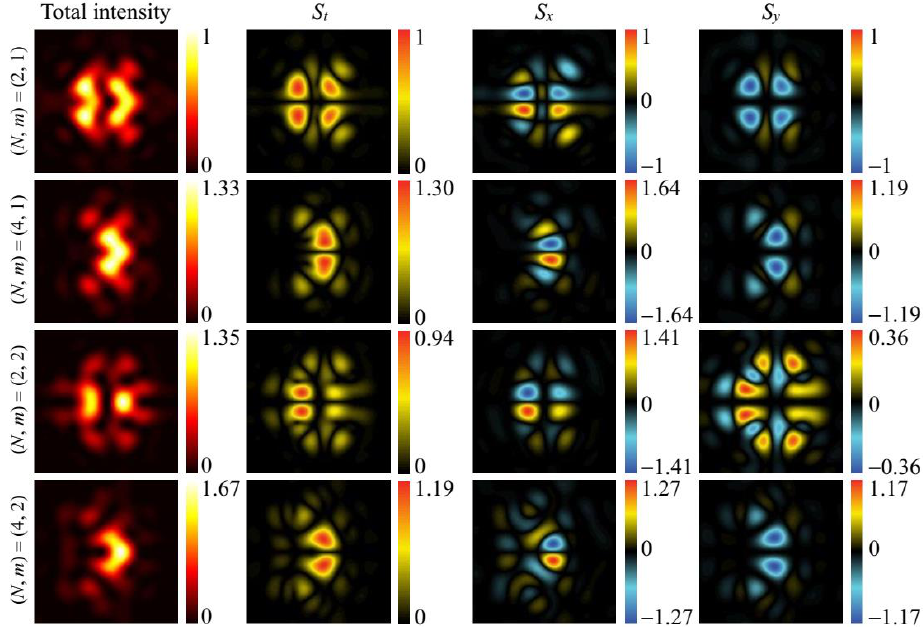
Figure 4. The total intensity and transverse SAM density of the tightly focused SM-HP-VOF when ( N , m ) = (2, 1), (4, 1), (2, 2) and (4, 2) in the four rows, respectively. The first column shows the total intensity of the tightly focused SM-HP-VOF. For the transverse SAM density, the transverse component S t , x -component S x , and y -component S y are shown in the second to fourth columns, respectively. The numerical aperture of the focal lens is NA = 0.95 , and any picture in the focal plane has a size of 4 λ × 4 λ , with λ being the wavelength.